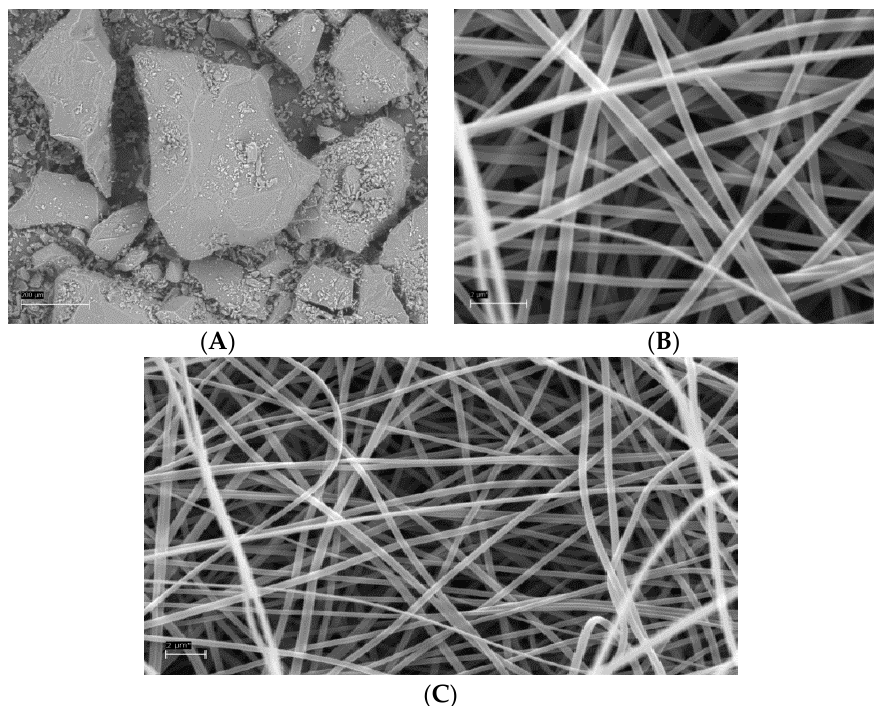
Figure 4. The SEMs of an isolated and milled HAE powder ( A ) and the amphiphilic electrospun NFs ( B , C ) used as a solid template for the self-assembled liposomes. Scale bar 200 µm ( A ) and 2.0 µm ( B , C ).